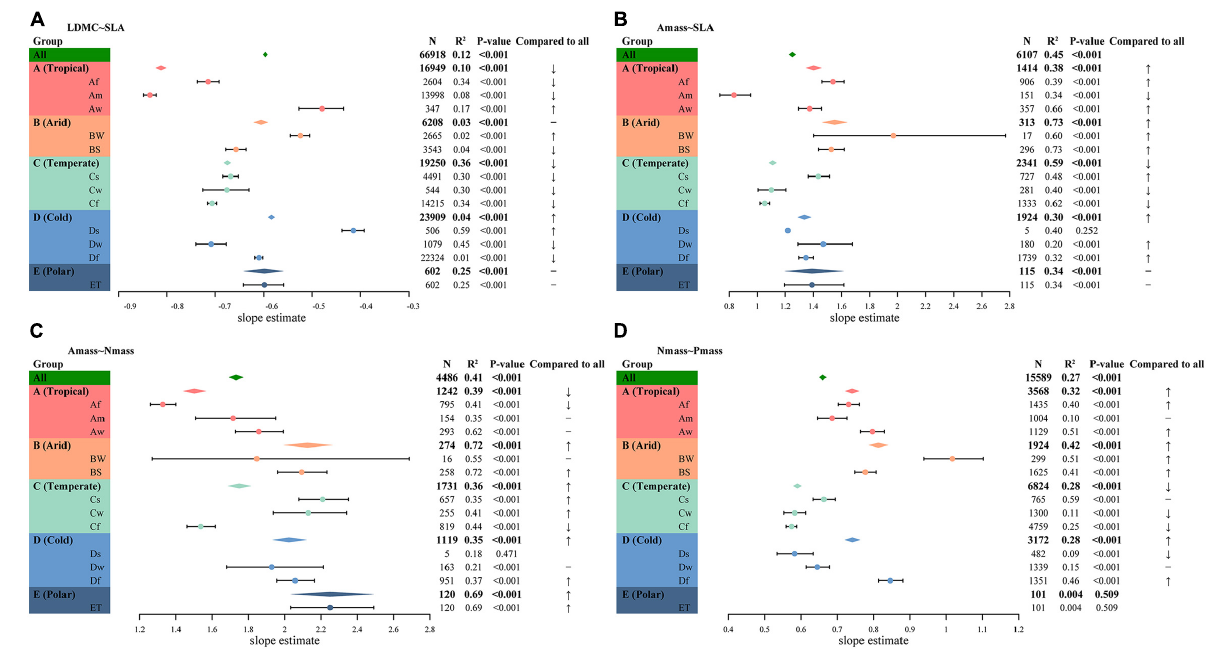
FIGURE 3 | Leaf trait relationships within different climate regions. (A) LDMC–SLA relationship. (B) Amass–SLA relationship. (C) A mass –N mass relationship. (D) N mass –P mass relationship. The diamond represents the fitted standardized major axis (SMA) slope estimate for all observations globally or within a subgroup. The points with error lines give the slope estimates and 95% confidence intervals for each climate type. A “ ↑ ” indicates the slope is significantly higher than the global estimate ( P < 0.05), “ ↓ ” indicates the slope is significantly lower than the global estimate ( P < 0.05), “ − ” indicates the slope is not significantly different from the global estimate ( P > 0.05). In addition, the sample sizes, coefficients of determination ( R 2 ), and P -values for all SMA fits are